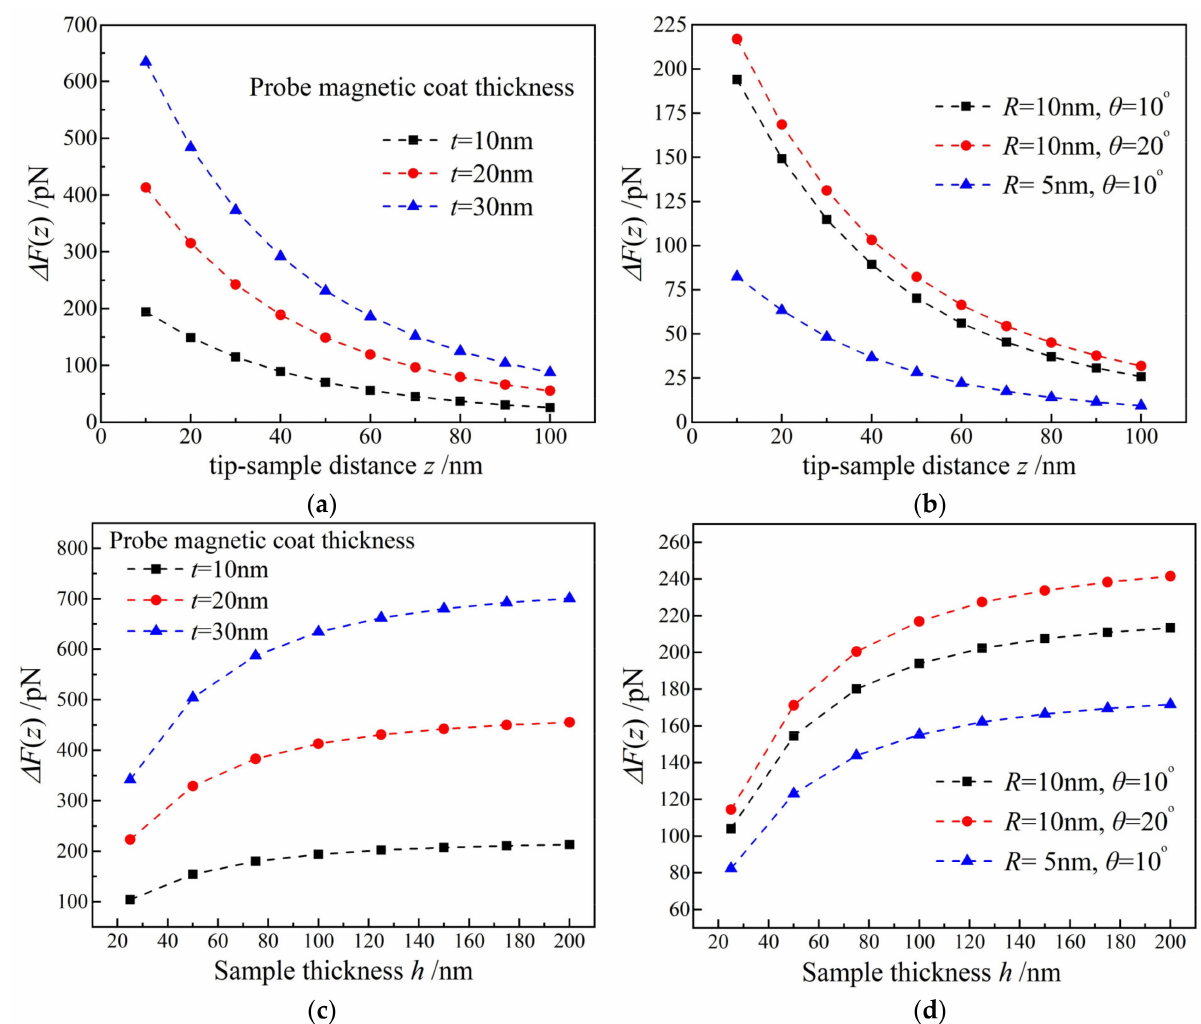
Figure 5. Magnetic forces varying with ( a , b ) distance between probe tip and sample; and ( c , d ) sam- ple